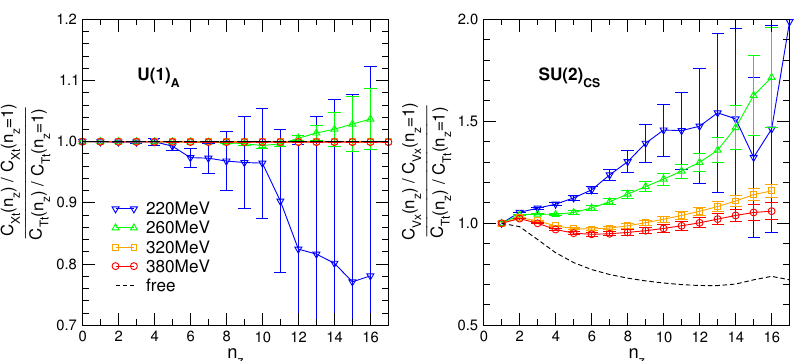
Figure 6. Ratios of normalized correlators that are related by U ( 1 ) A and SU ( 2 ) CS symmetries. The figure is from Ref. [16].